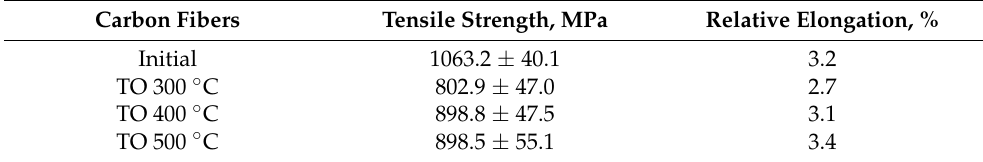
Table 4. Results of tensile strength tests of carbon